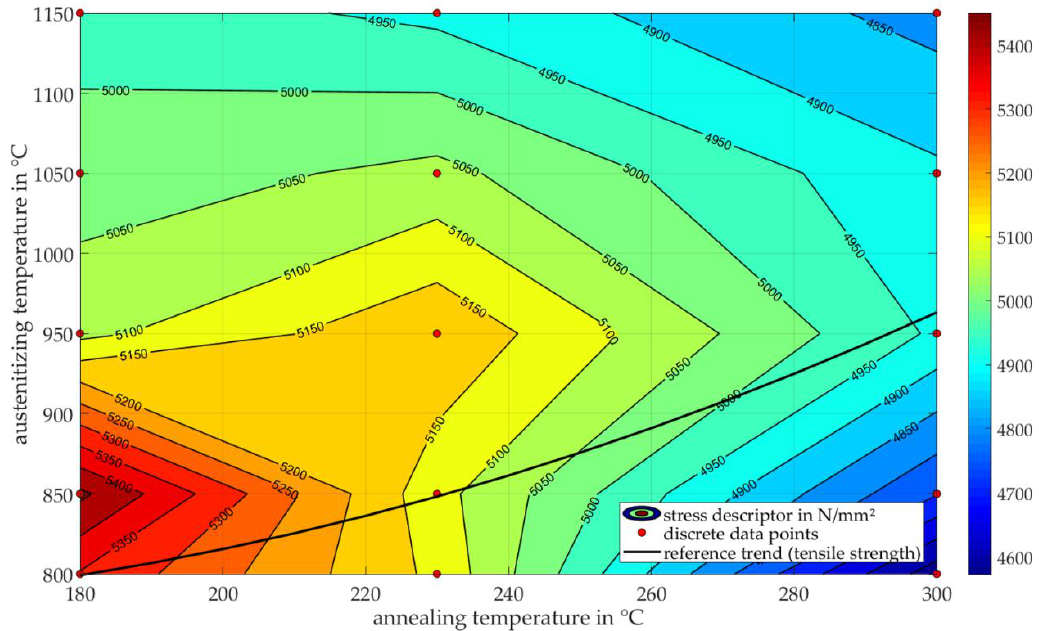
Figure 9. Contour plot ( T A over T T ) of experimentally determined equivalent stress values σ ( ε = 5% ) at strains of 5% in N / mm 2 as a descriptor of micro compression tests on spherical 100Cr6 samples, with investigated data points (red dots) and a comparative reference line (black) for the possibility of transferability to the trend of tensile strength of conventional tensile tests [19].